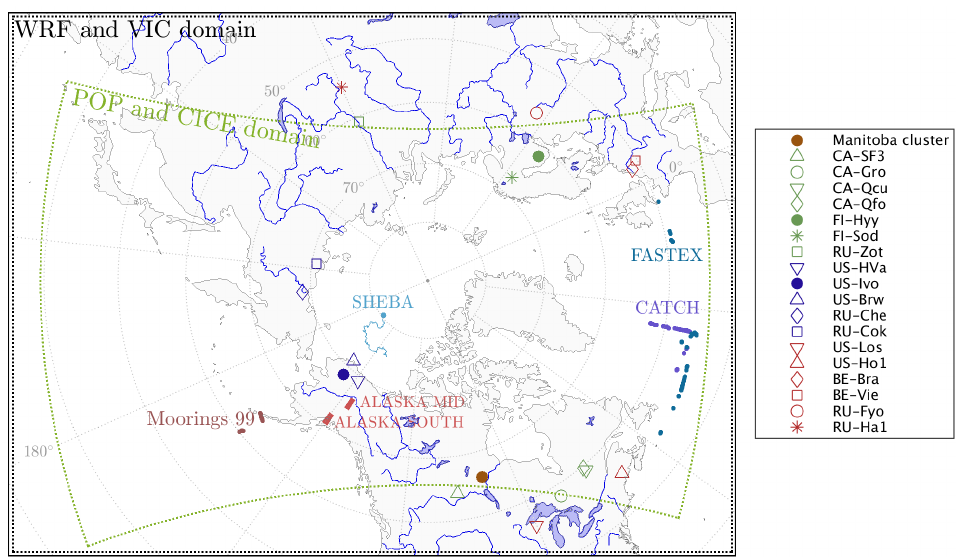
Figure 1. The RASM1 domains for the atmosphere (WRF) and land models (VIC) and for ocean (POP) and sea ice (CICE) models. The tracks of the ocean ship cruises (Moorings ’99, CATCH, and FASTEX) and SHEBA are included. The locations of the flux towers used in this study are also indicated by the symbols in the legend. The solid brown circle indicates the location of the Manitoba cluster and the three other towers that are shown in Figs. 8 and 11. The other symbols are the other flux towers. The two regions for snow depth evaluation with upscaled surface observations are also